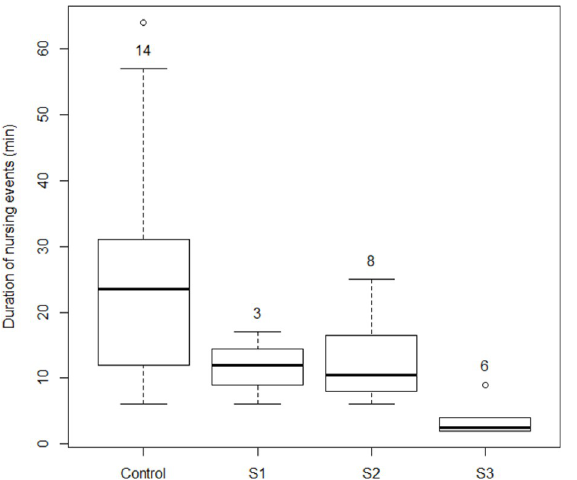
Fig 4. Nursing duration (min) under different disturbance scenarios and the control (no disturbance). Boxplots depict mean (horizontal line), standard deviation (box), and maximum and minimum values (bars). Circles denote outliers. Numbers correspond to the number of observations for each scenario. Scenario 1 (S1)–although nursing is momentarily interrupted by a disturbance, the mother-pup pair does not flush and continues to nurse; Scenario 2 (S2)–nursing is interrupted by a disturbance and the pair flushes, but recovers in less than 10 min and continues to nurse; and, Scenario 3 (S3)–nursing is interrupted by a disturbance, the pair flushes, and nursing does not resume until the end of the low tide cycle occurring during the sampling effort conducted on that day. The control observations (C) comprised nursing events that were not interrupted because no disturbance source was